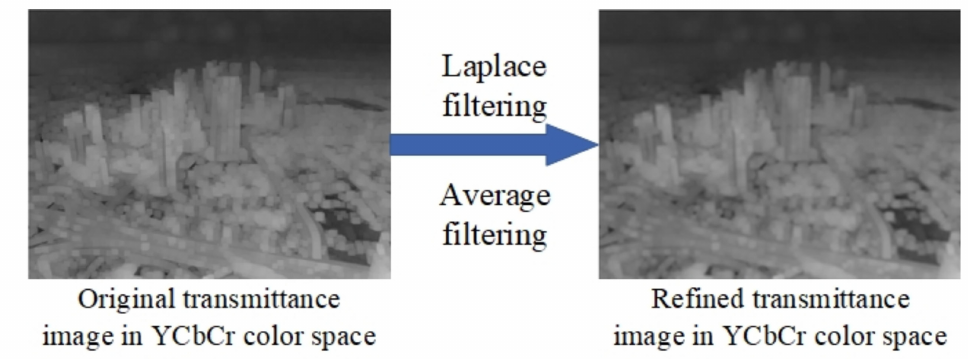
Figure 9. Flow chart of refining rough transmittance in YcbCr color